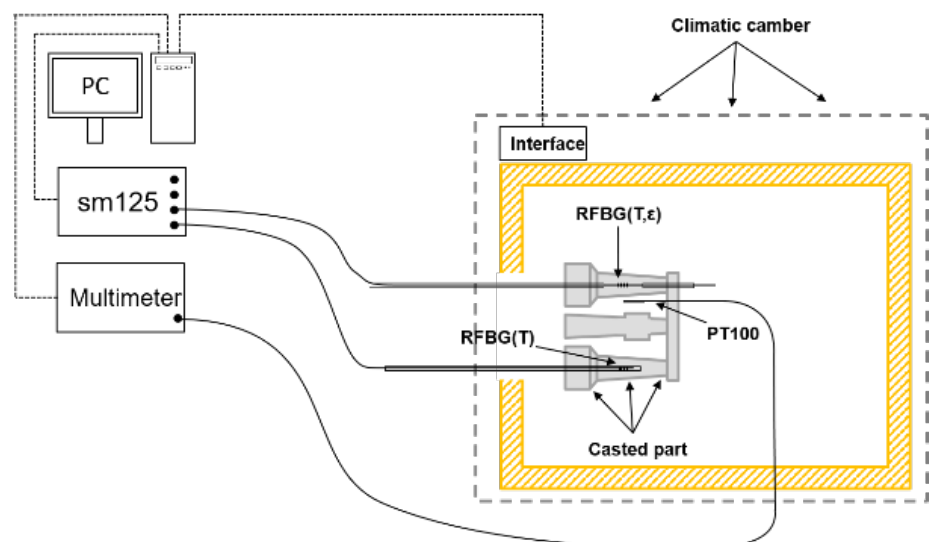
Figure 12. Measurement setup for the temperature characterization of embedded RFBGs in an aluminum casted part. A Pt100-temperature sensor was placed next to the casted part. The spectra of the RFBGs were recorded by a sm125 4-Channel interrogator and the resistance of the Pt100 was measured with a multimeter (Keithley2000, Tektronix GmbH, Cologne,